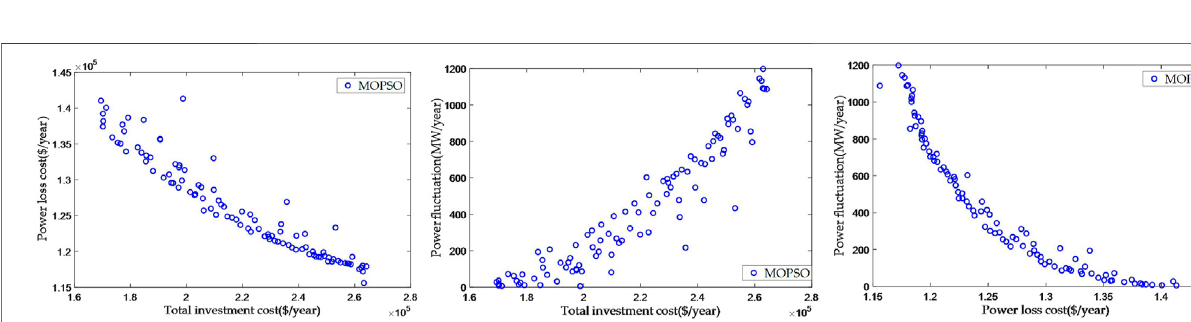
FIGURE 5 | Typical daily curves: (A) hourly load curves; (B) hourly wind and PV power curves.